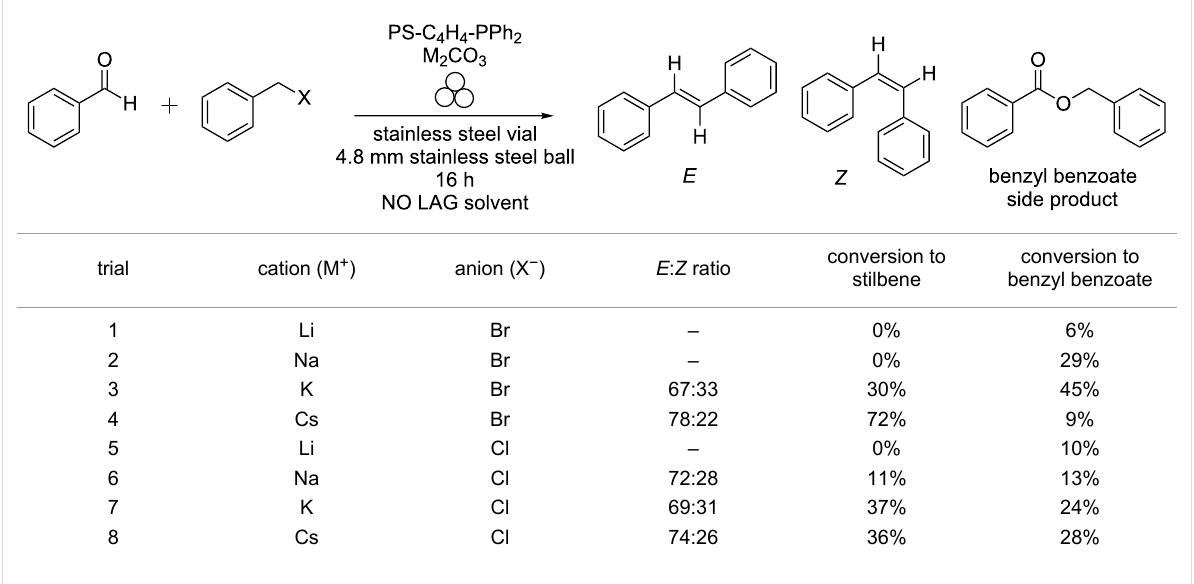
Table 4: Counter-ion partnerships in the solvent-free mechanochemical Wittig